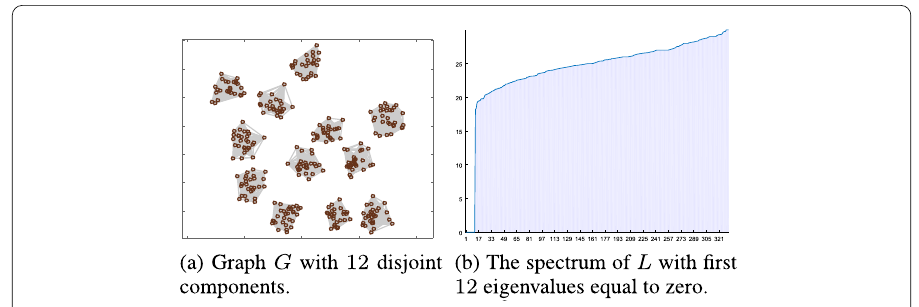
Figure 6 Graph G (immersed in R 2 for visualization) and its spectrum. Each individual cluster in the graph is G j , j = 1,2, ...